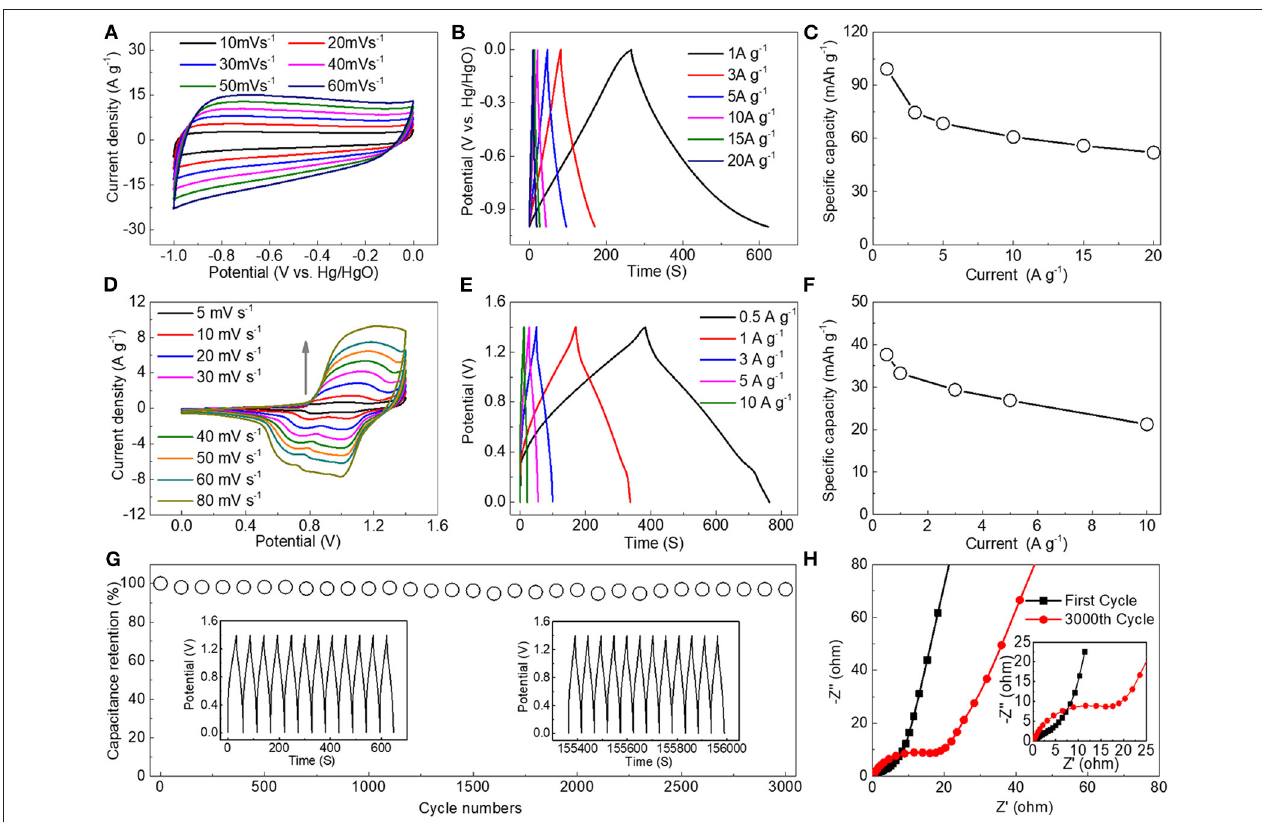
FIGURE 7 | Electrochemical properties of HEESDs: (A) CV and (B) charge-discharge curves of the commercial graphene electrode at various scan rates and current densities; (C) Specific capacity at different current densities under a three-electrode test system with the commercial graphene; (D) CV and (E) charge-discharge curves of the BFO-10%Ca//commercial graphene HEESDs at various scan rates and current densities; (F) The relationship between current density and capacity; (G) Cycling performance of the HEESDs at a current density of 5A g − 1 ; (H) EIS comparison curves of the HEESDs for the first cycle and 3,000th